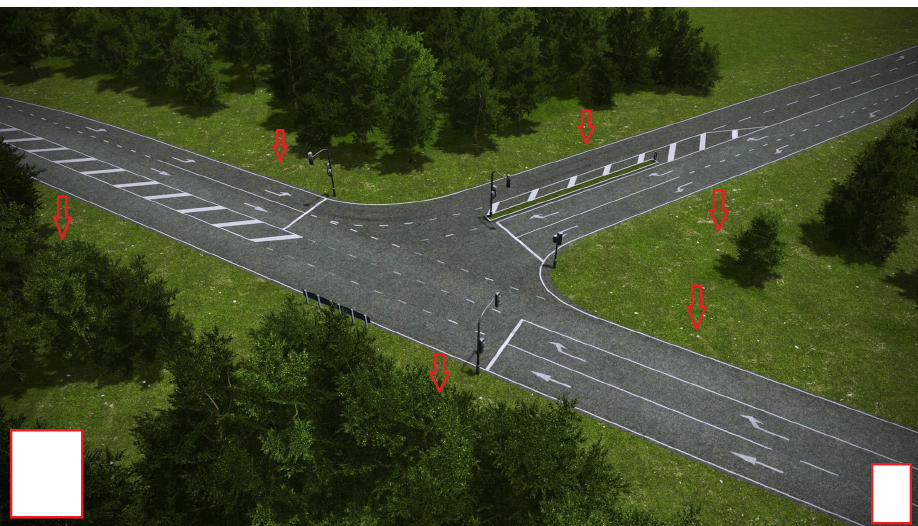
Figure 2. Sensors placement in the immediate vicinity of the